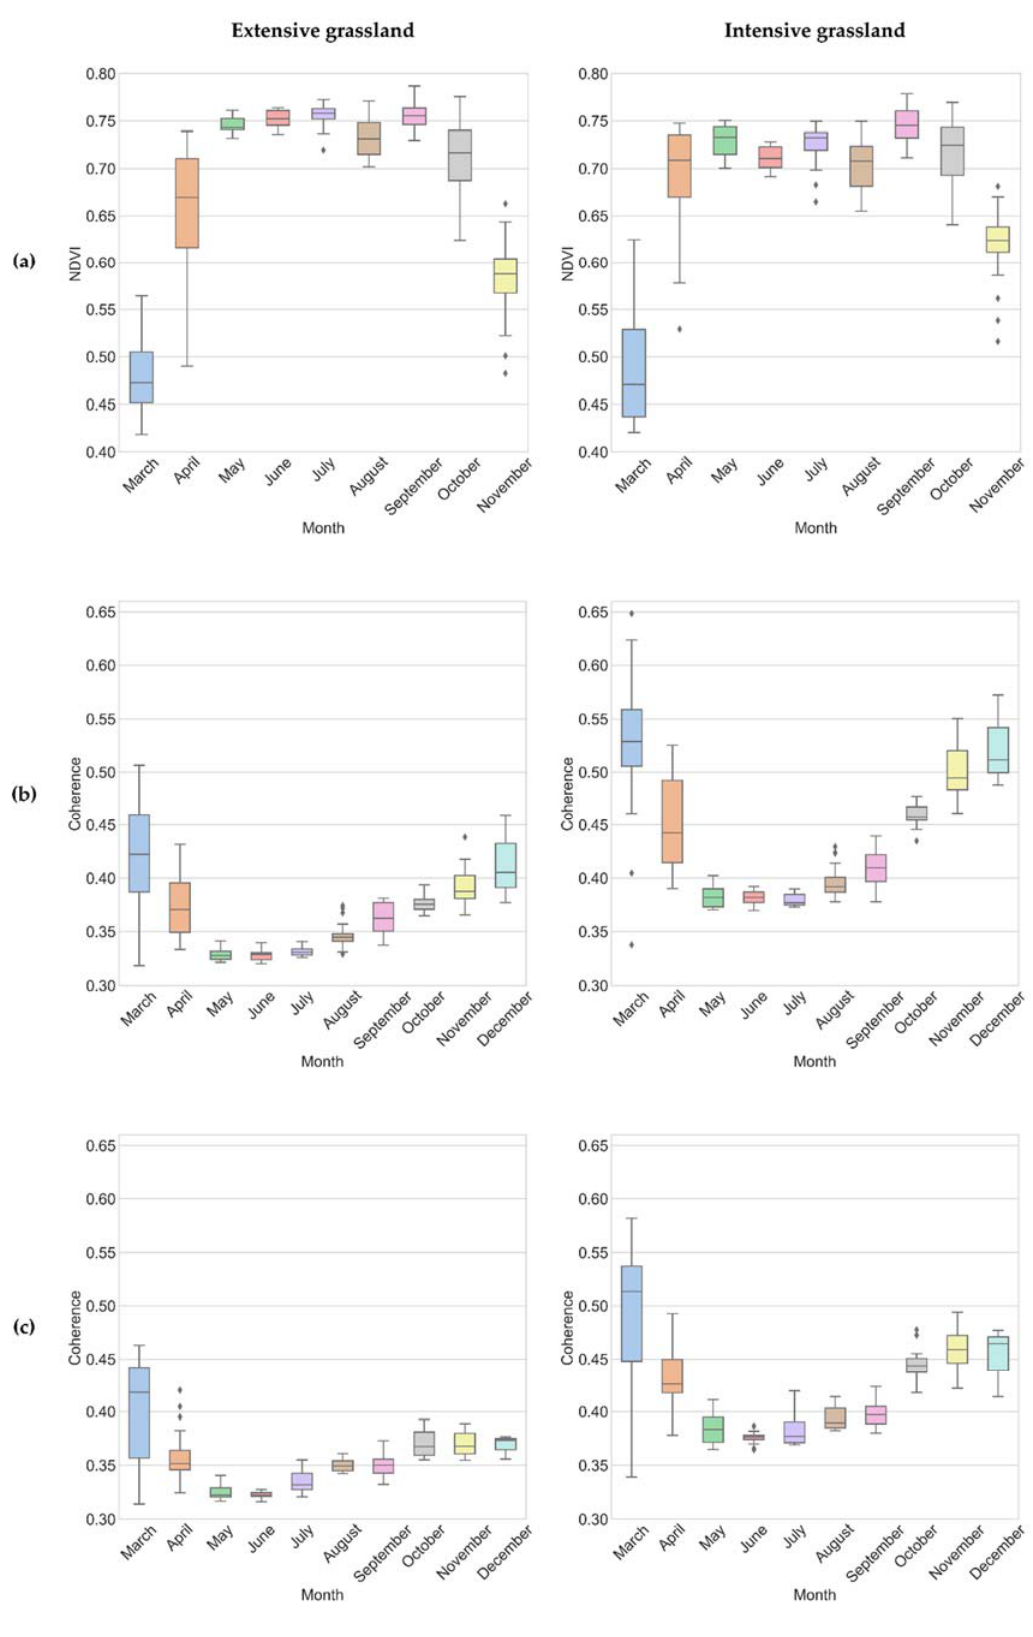
Figure 5. Boxplots of monthly average NDVI ( a ), coherence ascending ( b ) and coherence descending ( c ) for extensive and intensive managed grassland in all analysed years.